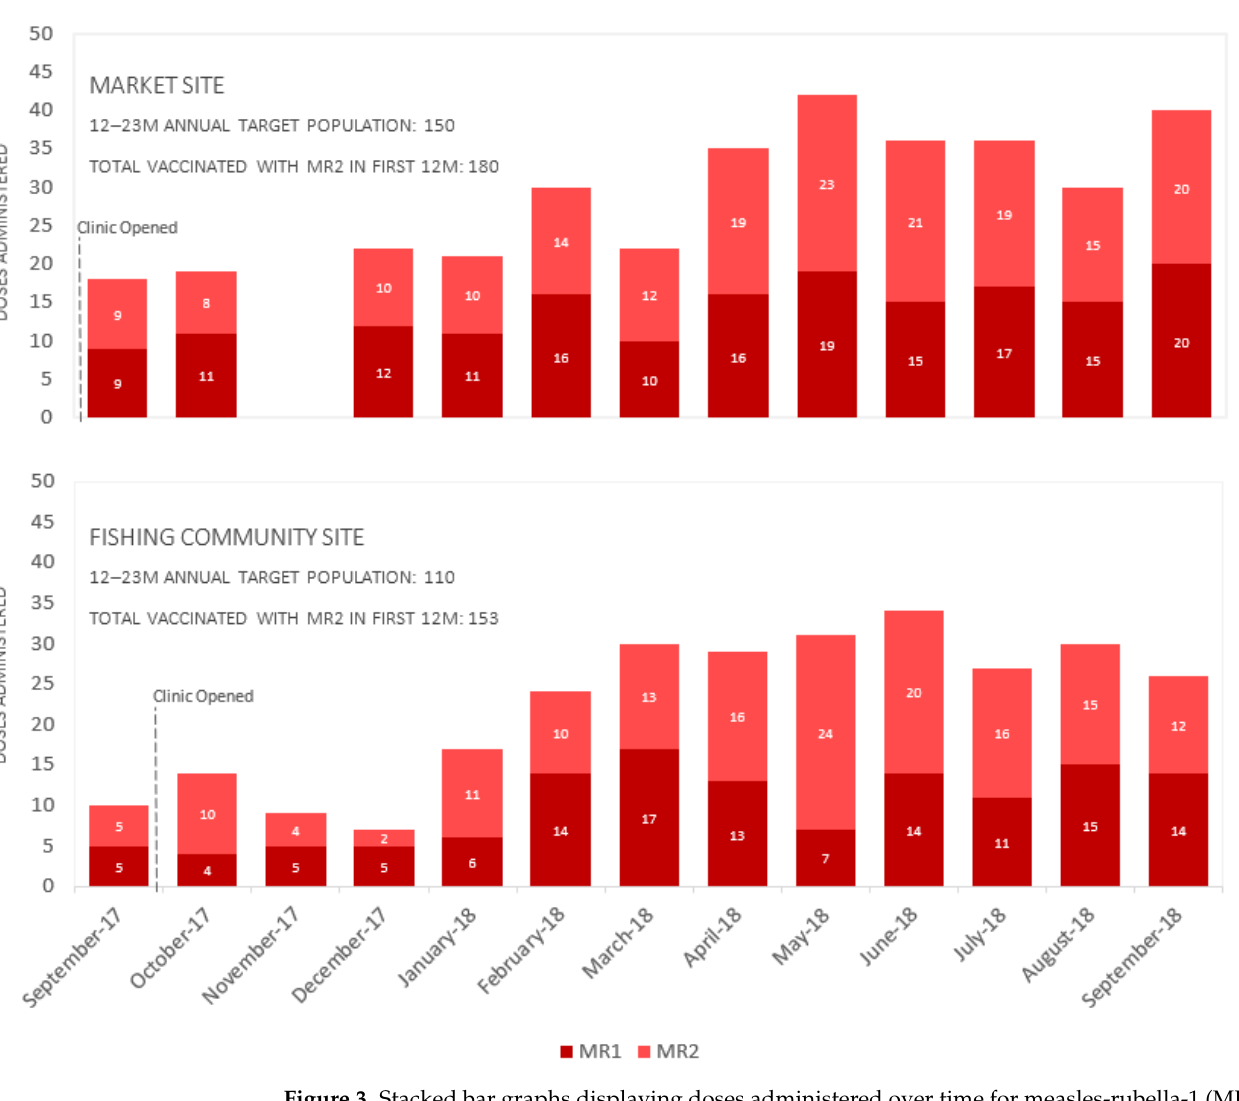
Figure 3. Stacked bar graphs displaying doses administered over time for measles-rubella-1 (MR1) and measles-rubella-2 (MR2) at both container clinic sites from 2017–2018. Abbreviations: MR1 (measles rubella vaccine dose 1); MR2 (measles rubella vaccine dose 2). Note: missing data for the market site in November 2017.